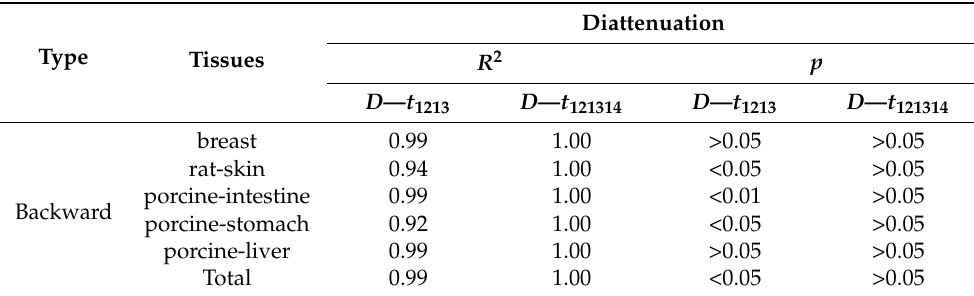
Figure 1. Comparison of forward measured MMT and MMPD diattenuation parameters of thin tissue samples. ( a ) MMPD parameter D plotted against its counterpart MMT parameter t 1213 for correlation analysis with all 7 kinds of thin tissue samples. ( b ) Statistical analysis bar chart of MMPD parameter D and MMT parameter t 1213 for each kind of thin tissue samples. ( c ) MMPD parameter D plotted against its counterpart modified MMT parameter t 121314 for correlation analysis with all 7 kinds of thin tissue samples. ( d ) Statistical analysis bar chart of MMPD parameter D and modified MMT parameter t 121314 for each kind of thin tissue samples. Table 3. Correlation and statistical analysis comparison results between backward measured MMT and MMPD diattenuation parameters for each kind of bulk tissue